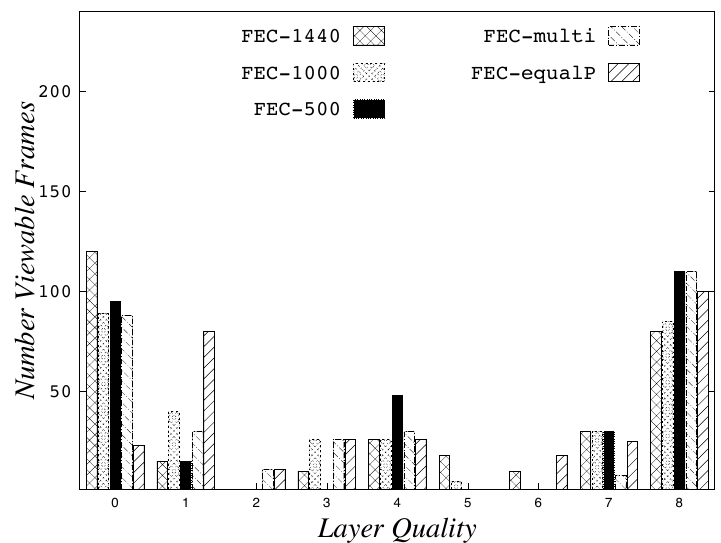
Figure A9. Example of the number of viewable layers for SVC-SC, for each of the FECPacket thres , at a packet loss rate of 10% and a GOP of 8.